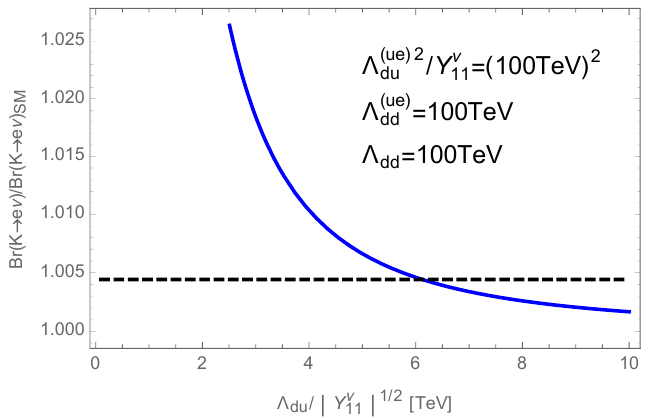
Figure 6 . The predictions of Br ( K ! e (cid:23) ), depending on (cid:3) du = our predictions in the NO case with (cid:3) dd = (cid:3) ( ue )